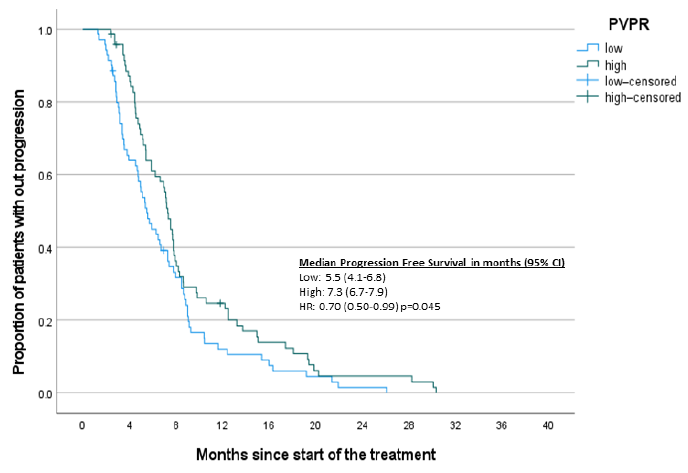
Figure 4. Kaplan–Meier curves for PFS-NLR.